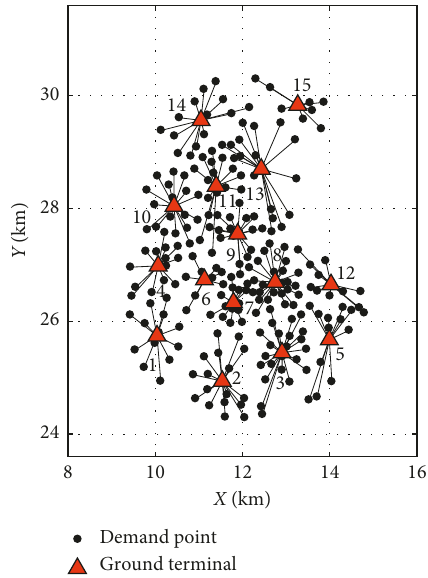
Figure 5: Service scope of M-ULS and GT location.